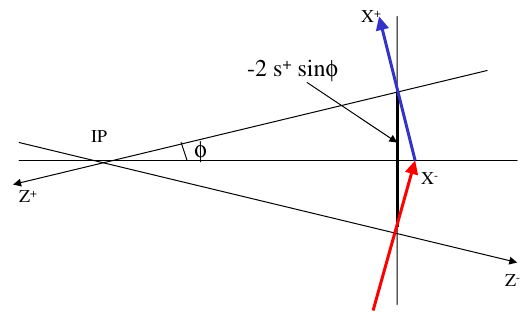
FIG. 8. (Color) Two colliding slices at their actual collision point with an angle 2 (cid:2) (cid:14) . The colors also indicate the coor- dinates at which the transverse beam-beam forces are